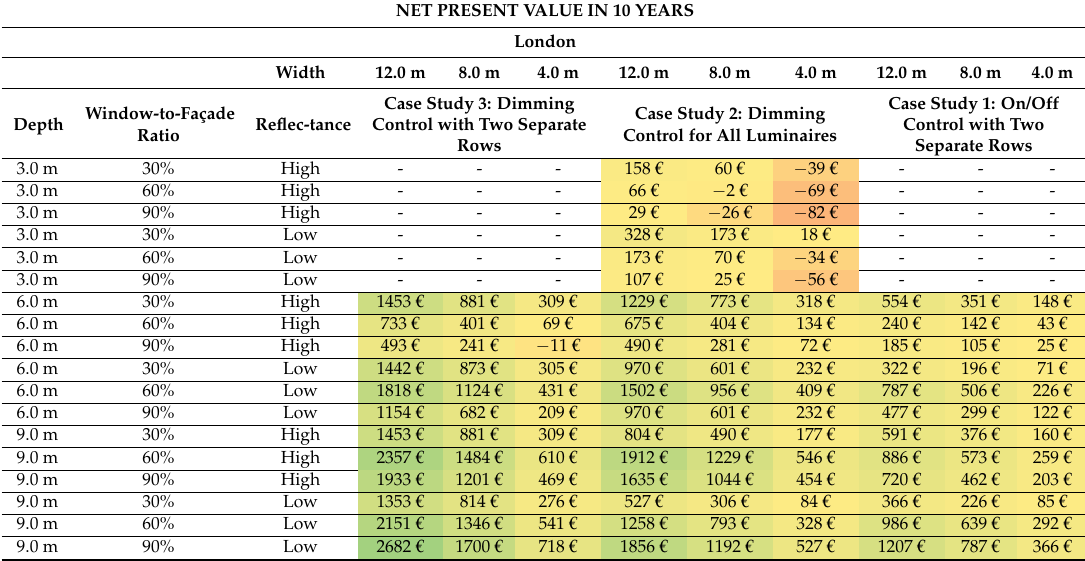
Table 15. Net present value in 10 years according to different lighting smart controls in London.